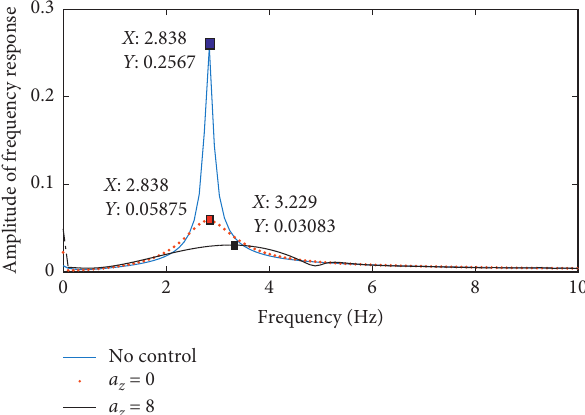
Figure 8: Amplitude-frequency characteristic of the free